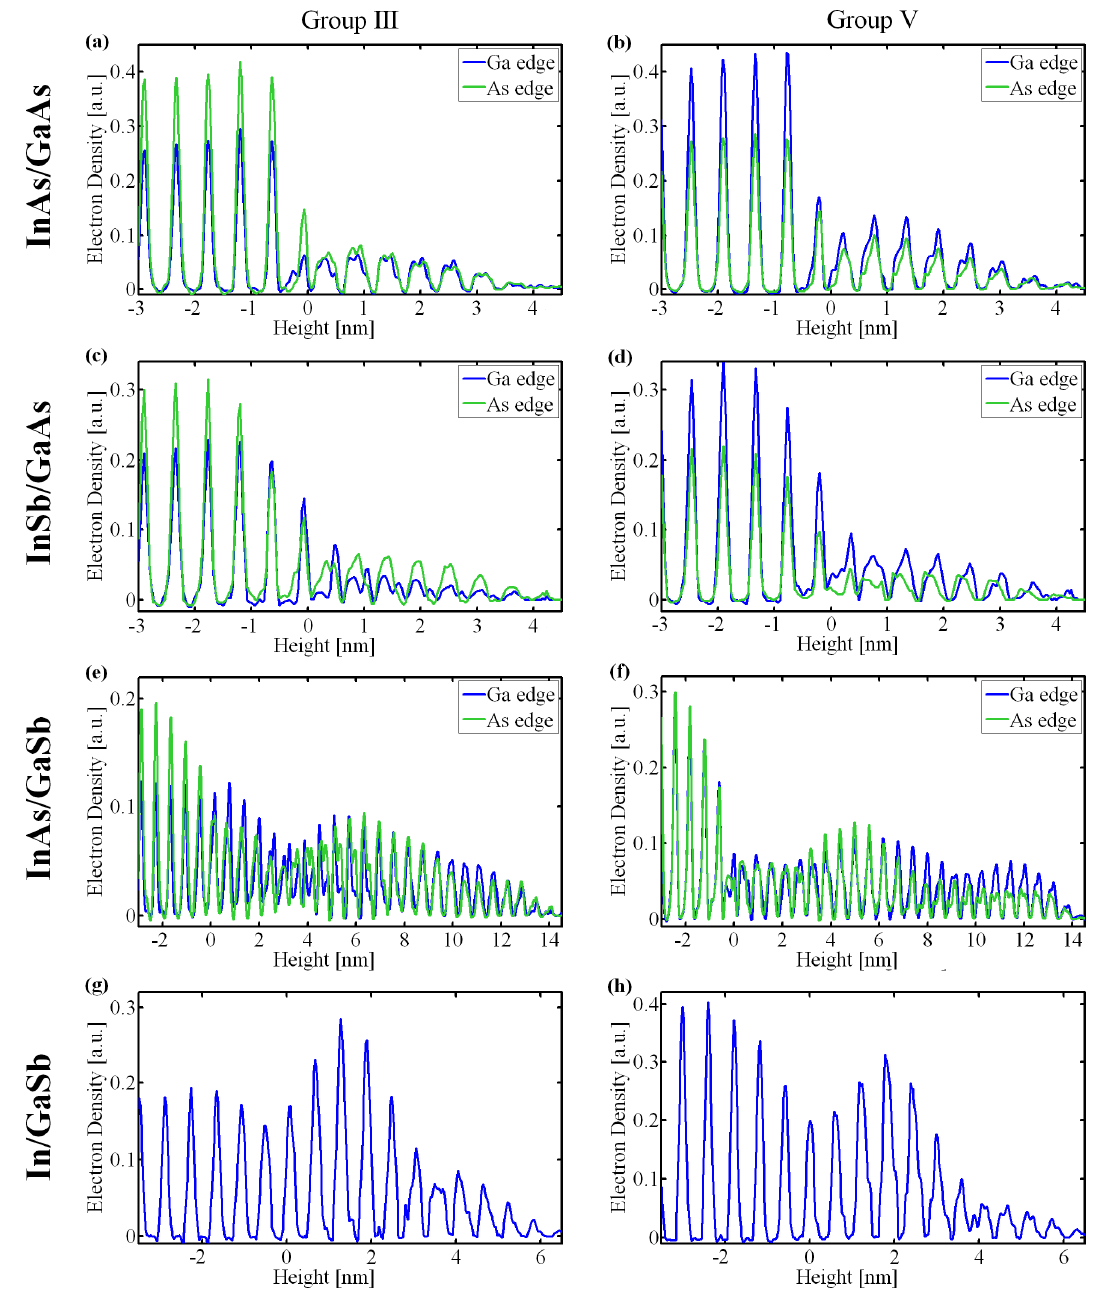
Figure 2. Electron density profiles of the different QDs systems; InAs/GaAs, InSb/GaAs, InAs/GaSb, In/GaSb . For each, a profile line passing through the group III elements (left) and the group V elements (right) are displayed. Line profiles are plotted for two different beam energies used: below the Ga K-edge and below the As